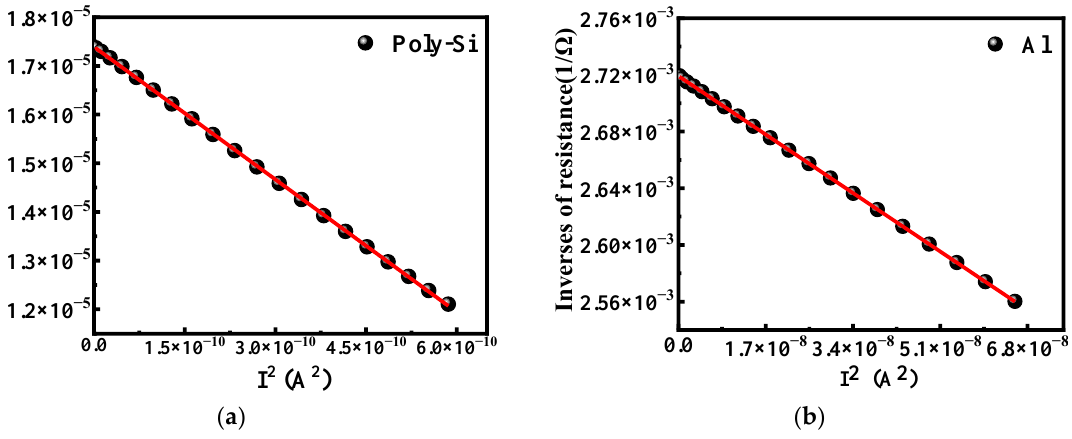
tion results of 2.90  10 − 7 W/K and 1.25  10 − 6 W/K, respectively.